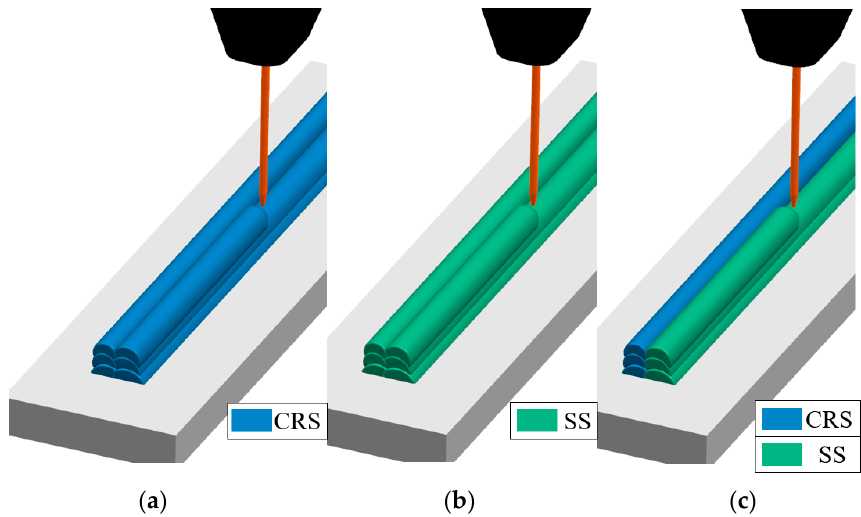
Figure 1. Diagrams of the deposition strategy for ( a , b ) single ‐ and ( c ) multi ‐ material.